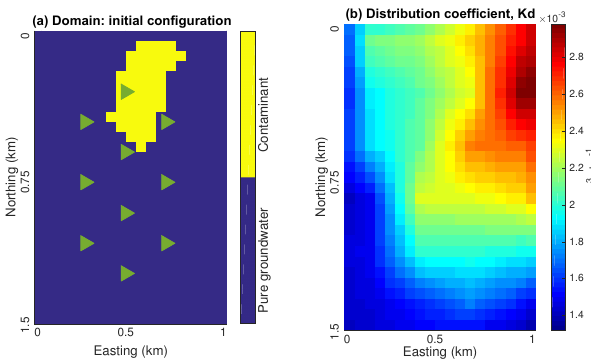
Figure 2. (a) Initial configuration and geometry of the study area, located at the port of Rotterdam. The blue part is the domain area (1 . 5km 2 ) of each layer and the yellow region is the plume of chlo- rinated hydrocarbon contaminants located in layer 60 at a depth of 22 . 5m below the mean sea level. The green triangles indicate the measurement locations collected from layers 30, 50, 70 and 90; (b) 2-D spatial configuration of sorption (distribution coefficient) for trichloroethene (TCE) averaged over the first 10 layers of the